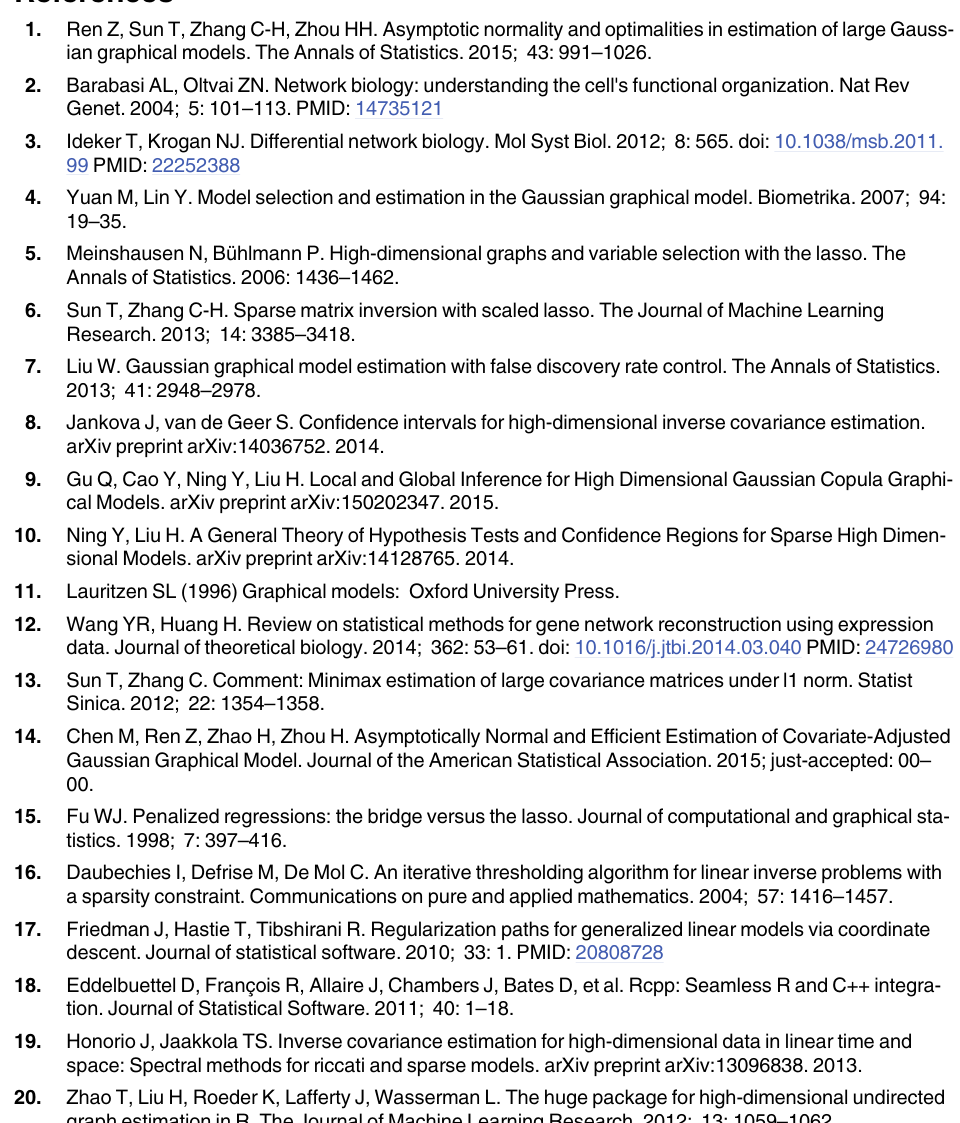
S1 Table. Coded protein level data in AD